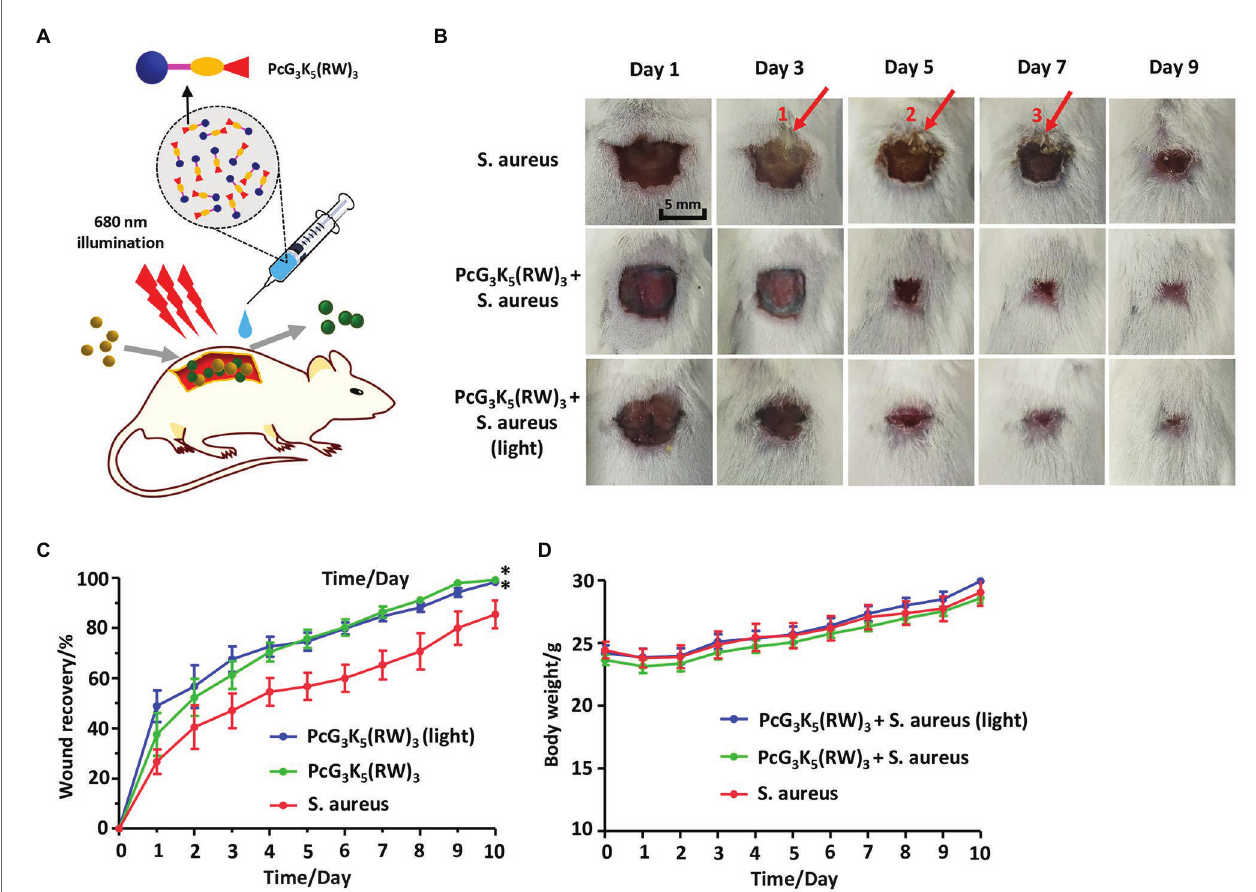
FIGURE 6 | PcG 3 K 5 (RW) 3 promoted wound healing of bacteria-infected wounds. (A) Schematic of animal experiment using PcG 3 K 5 (RW) 3 . (B) Images of the wounds in the wound healing model treated in 10 days after surgery. Scale bar: 5 mm (arrow 1 showed the infected area at wound edge, and arrows 2 and 3 showed the scab formed in infected area). (C) Effects of PcG 3 K 5 (RW) 3 (final concentration of 20 μ M) on the healing of S. aureus treated excisional wounds in mouse ( n = 6 per group). (D) The mice gained body weight constantly, demonstrating safety of the antimicrobial peptide. Error bars indicated SD for three replications. * indicated a significant difference ( p < 0.05) from the corresponding control